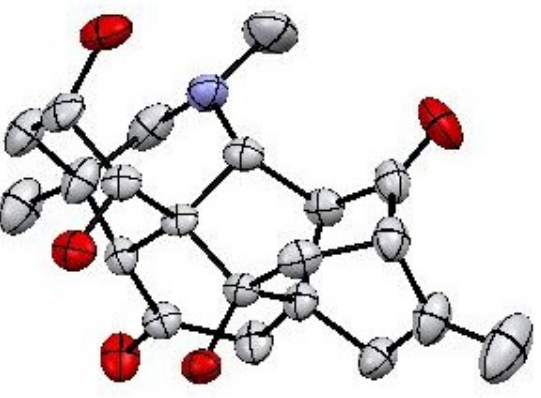
Figure 4. Structural representation of Compound 1 , with 50% probability of thermal ellipsoids, hydrogens were emitted for clarity.